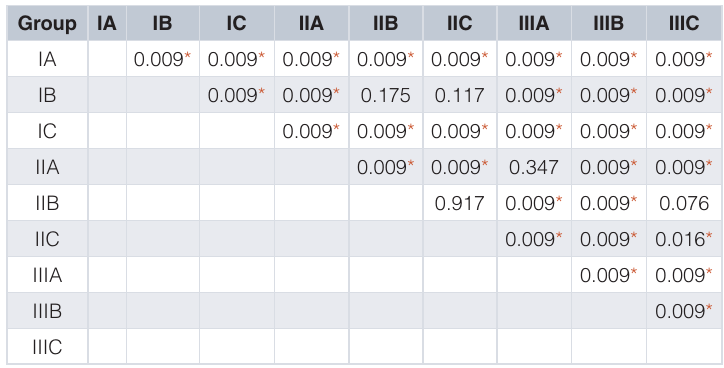
Table 2. Mann-Whitney test results between adhesive materials. *Statistically significant